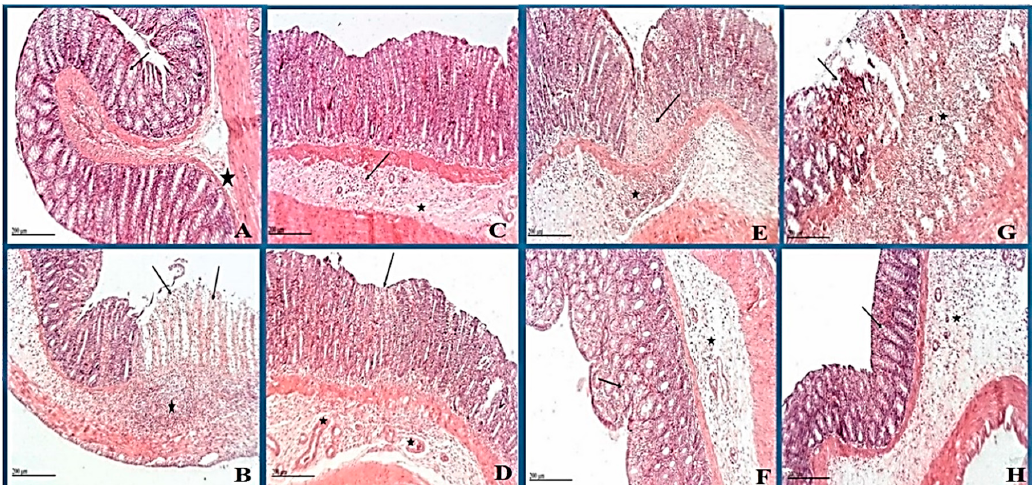
Figure 5. Photomicrograph of rat colon shows ( A ) negative control: normal histological structures of the colon with intact mucosa (star) including intestinal crypt with abundant goblet cells (arrow). ( B ) Positive control: extensive focal erosions and ulceration (arrow) of intestinal mucosa with necrotic tissue debris. Extensive inflammatory cells infiltration including mononuclear and polymorphonuclear cells in mucosa and submucosal layers (star) accompanied with moderate submucosal edema. ( C ) Dexamethasone standard: Apparent intact glandular mucosa and lining epithelium with moderate inflammatory cells infiltration in deeper mucosa and submucosal layer (arrow) accompanied with mild submucosal edema (star). ( D ) Nano-Ag: few focal areas of necrosis in the superficial zone of intestinal mucosa (arrow) with many intact glandular elements. Mild submucosal edema and inflammatory cells records with many dilated and/or congested submucosal blood vessels (star). ( E ) ASBE: tiny focal erosions and ulceration (arrow) of intestinal mucosa with necrotic tissue debris. Focal inflammatory cells infiltration including mononuclear and polymorphonuclear cells in mucosa and submucosal layers (star) accompanied with mild submucosal edema. ( F ) ASBE plus nano-Ag: apparent intact mucosa including glandular structures with many goblet cells. Moderate inflammatory cells infiltration in interglandular tissue (arrow) as well as submucosal layer (star) with diffuse submucosal edema. ( G ) ASB nano-extract: erosions and ulceration (arrow) of intestinal mucosa with necrotic tissue debris. Inflammatory cells infiltration including mononuclear and polymorphonuclear cells in mucosa and submucosal layers (star) accompanied with mild submucosal edema. ( H ) ASB nano extract plus nano-Ag: apparent intact mucosa including glandular structures with many goblet cells(arrow) with fewer inflammatory cells infiltration records. Focal areas of submucosal edema (star) (Normal submucosa). (H&E stain, 100 X).; Scale bars for all figures (A-H) are 20 µm.